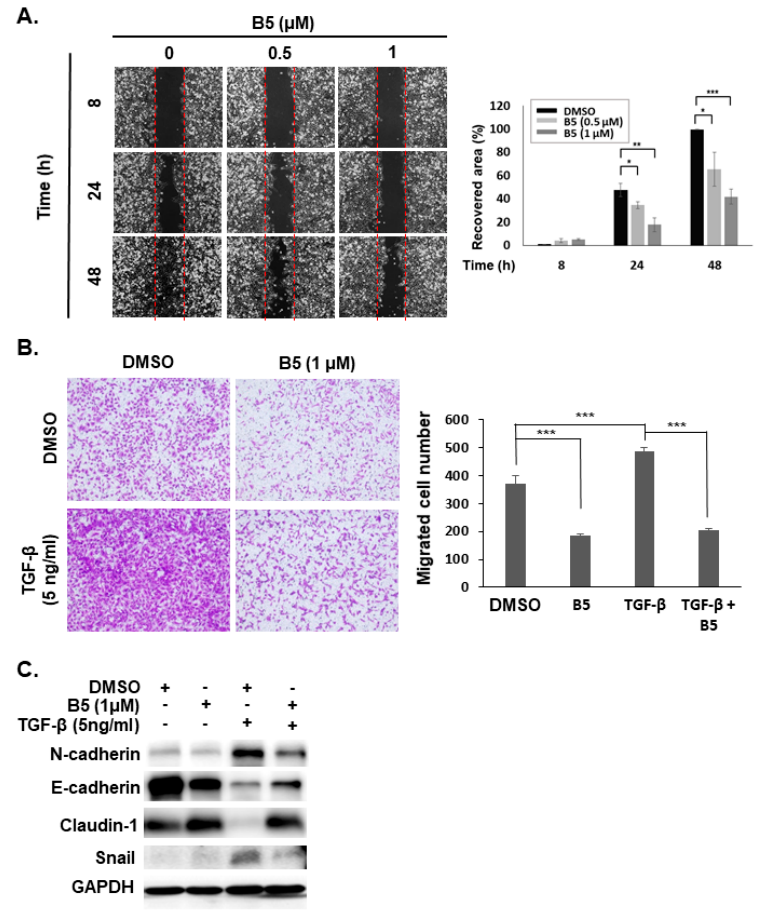
Figure 7. Enhancing autophagy further sensitizes A549 cells toward 9-O-farnesylberberrubine bro- mide treatment. A549 cells were incubated with B5, and autophagy was modulated with rapamycin, 3-MA or chloroquine. Cellular morphology and viability were examined using optical microscopy and CCK-8 assay in the cells administered with B5 (1 µ M), 3-MA (5 mM), chloroquine (10 µ M), and rapamycin (30 µ M) or a combination after 48 h of treatment. 3-MA was an initiated autophagy inhibitor. Chloroquine was an autophagic flux blocker. Rapamycin was used as an autophagy inducer. ** indicates p < 0.01; *** indicates p < 0.001.